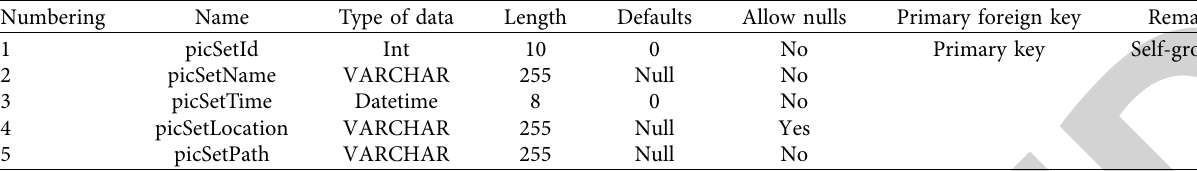
Table 4: Picture information record table.